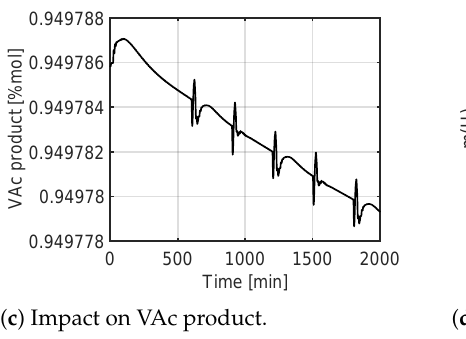
Figure 16. APT and attestation example.